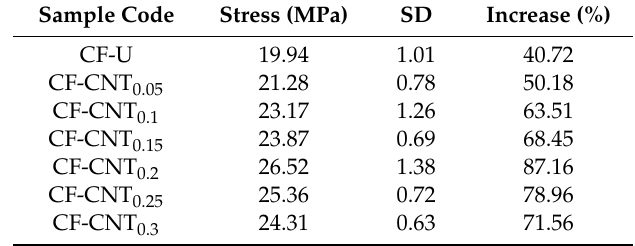
Table 4. Bond strength of samples cured under vacuum compression.